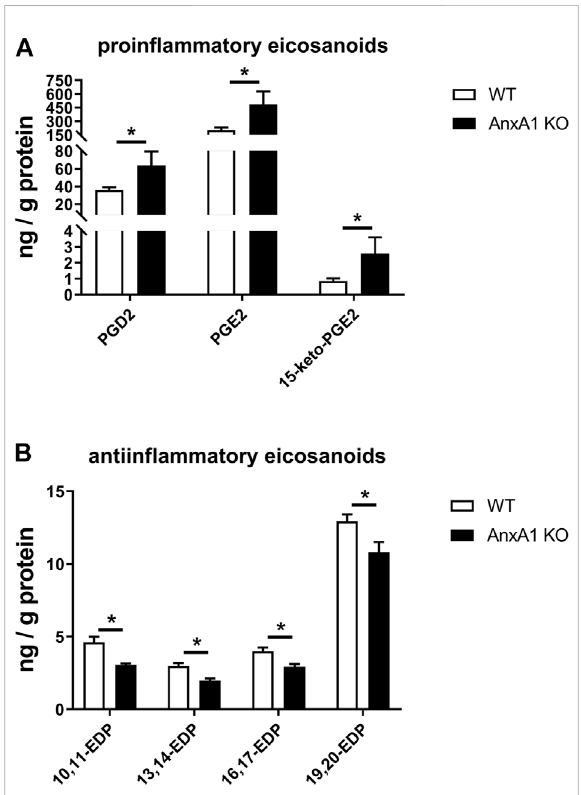
FIGURE 6 De fi ciency of annexin A1 regulates the abundance of proin fl ammatory and antiin fl ammatory eicosanoids. (A) Lipidomicsanalysisofproin fl ammatoryrenaleicosanoidspeciesin wildtype (WT) and annexin A1 (AnxA1)-de fi cient mice (AnxA1 KO)at d10after induction of crescentic glomerulonephritis shows signi fi cantly higher tissue levels for prostaglandin D2 (PGD2), prostaglandin E2 (PGE2) and of the principal PGE2 metabolite 15-keto-PGE2 in the AnxA1-KO mice as compared to nephritic WT mice. (B) Analysis of antiin fl ammatory epoxydocosapentaenoic acid (EDP) regioisomers shows signi fi cantly lower tissue levels for 10,11-EDP, 13,14-EDP, 16,17- EDP, and 19,20-EDP in AnxA1-KO mice at d10 after induction of crescentic glomerulonephritis as compared to nephritic WT mice. Statistical signi fi cance of changes was calculated using Student`s t-test; * p < 0.05; n = 5 per